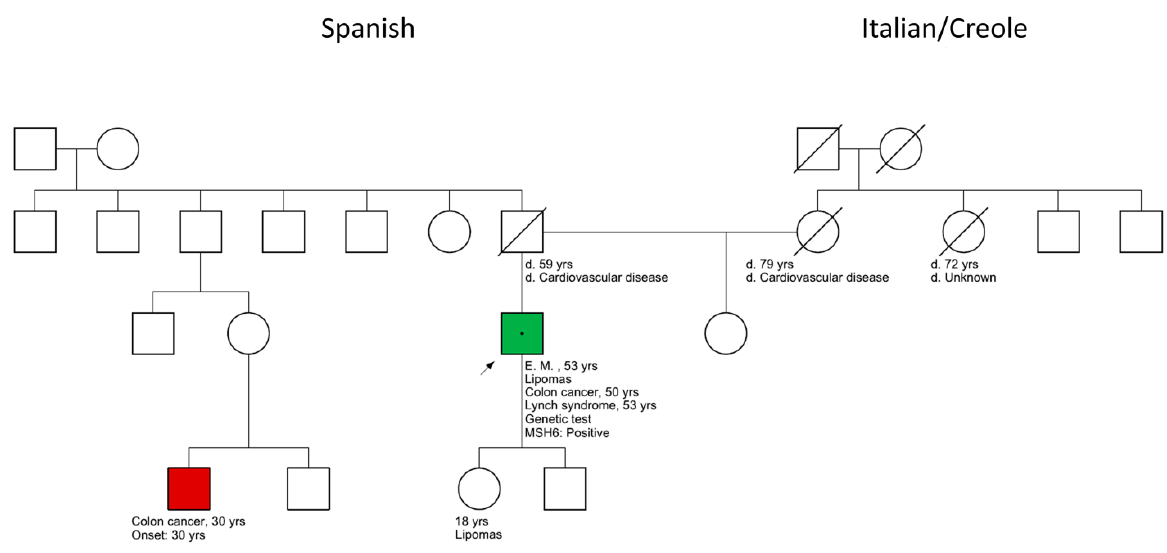
Figure 1. Family pedigree with known medical history. Ages represent (i) age of death for deceased subjects or (ii) age at the time of medical history collection for living family members.